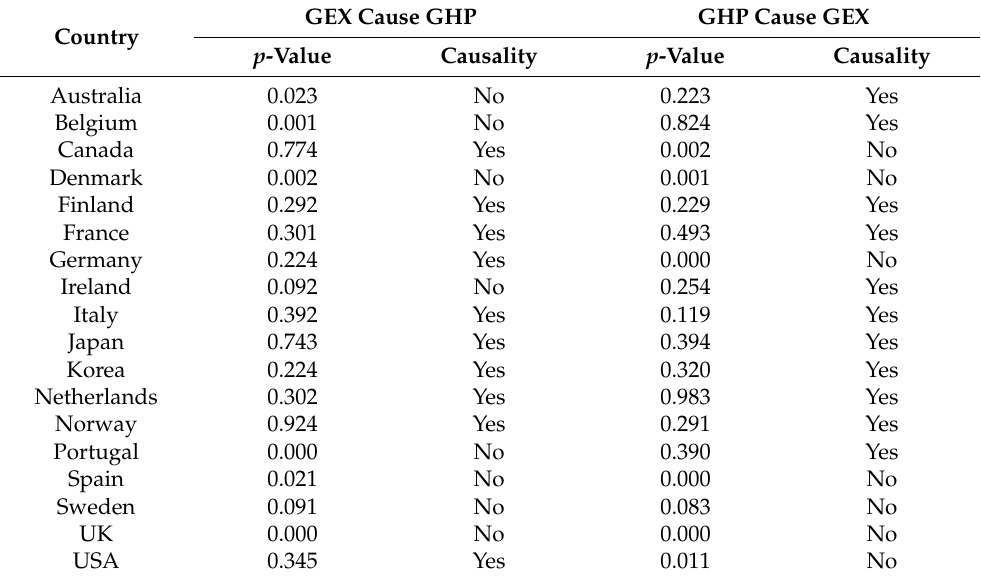
Table 6. The results of quantile Granger causality between housing prices and exchange rates in the normal market in OECD countries (quantile =